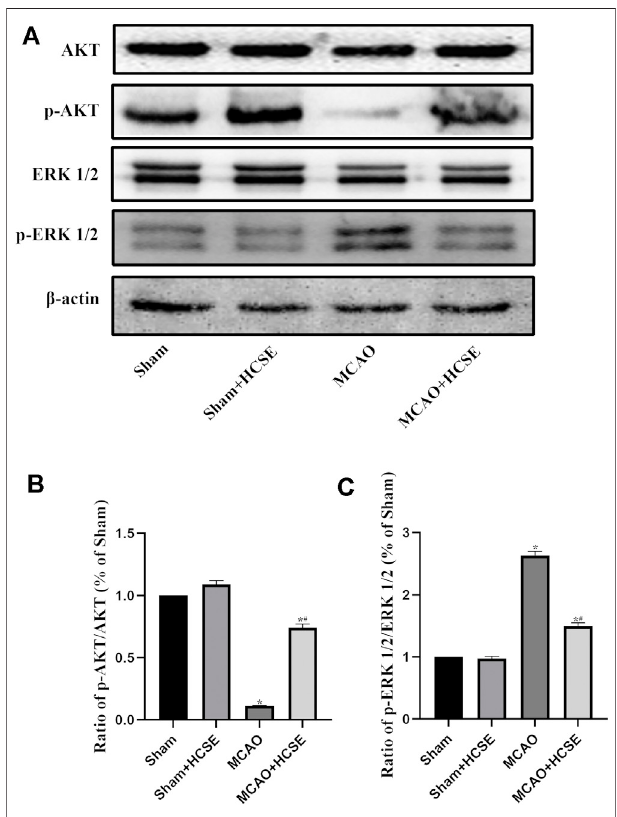
FIGURE 8 | Changes in the levels of proteins related to the AKT/p-AKT/ ERK1/2/p-ERK1/2 signaling pathway in the cortex. (A) Western blotting of relatedproteins. (B) Theratioofp-AKT/AKT. (C) Theratioofp-ERK1/2/p-ERK 1/2. ( n = 7 per group; * p < 0.05, signi fi cantly different from the corresponding Sham group, # p < 0.05, signi fi cantly different from the MCAO group).